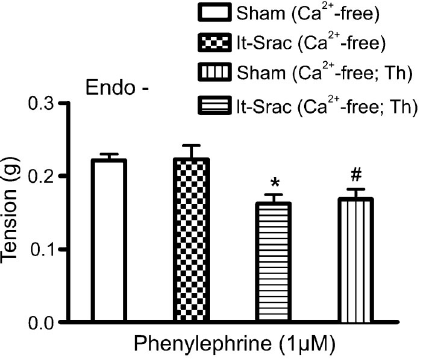
Figure 5. Transient contractile responses to phenylephrine in Ca 2++ -free medium after treatment with the sarco-/endoplasmic ATPase inhibitor thapsigargin (1 m M for 10 min). Transient contractile responses to phenylephrine (1 m M) were elicited in Ca 2++ -free medium in the presence or absence of thapsigargin (Th) in endothelium-denuded (Endo-) aortic rings prepared from rats 8 weeks after suprarenal abdominal aortic coarctation (lt- Srac) or sham surgery (Sham). Data are reported as means±SE grams of developed force (n=13-15). *P , 0.05, Sham (Ca 2++ - free) vs Sham (Ca 2++ -free; Th); # P , 0.5, lt-Srac (Ca 2++ -free) vs lt-Srac (Ca 2++ -free; Th); P not significant, Sham (Ca 2++ -free) vs lt-Srac (Ca 2++ -free), and Sham (Ca 2++ -free; Th) vs lt-Srac (Ca 2++ -free; Th) (one-way ANOVA with the Tukey post hoc test).